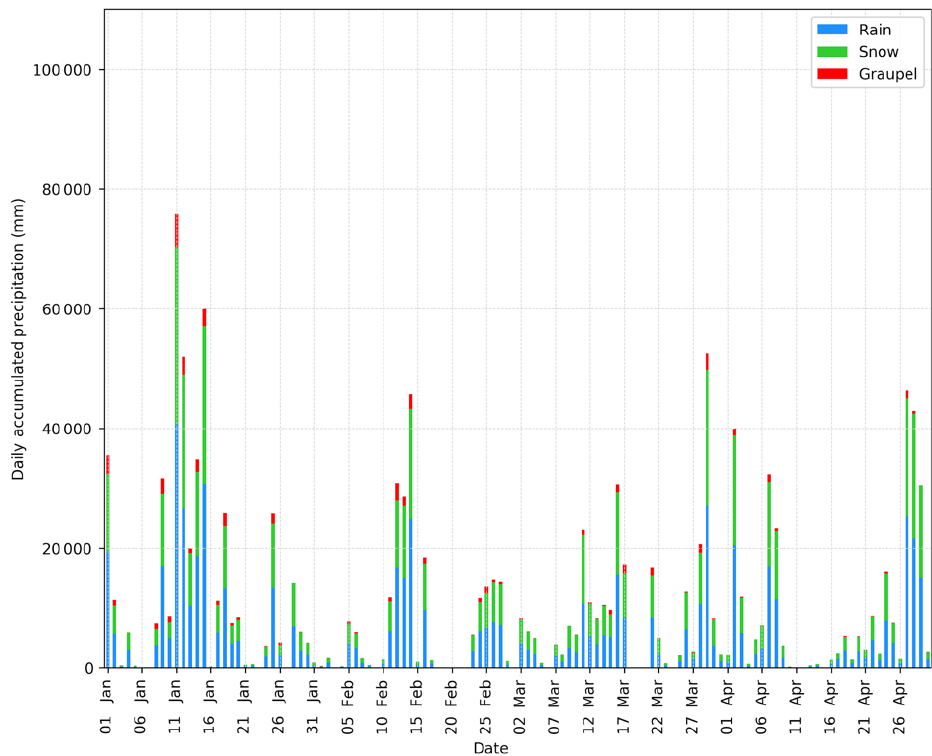
Figure 5. Daily accumulated precipitation (mm) within transition regions under CTRL over the January–April 2010 period and organized by rain (blue), snow (green) and graupel (red). Freezing rain occurrence was minimal and was not